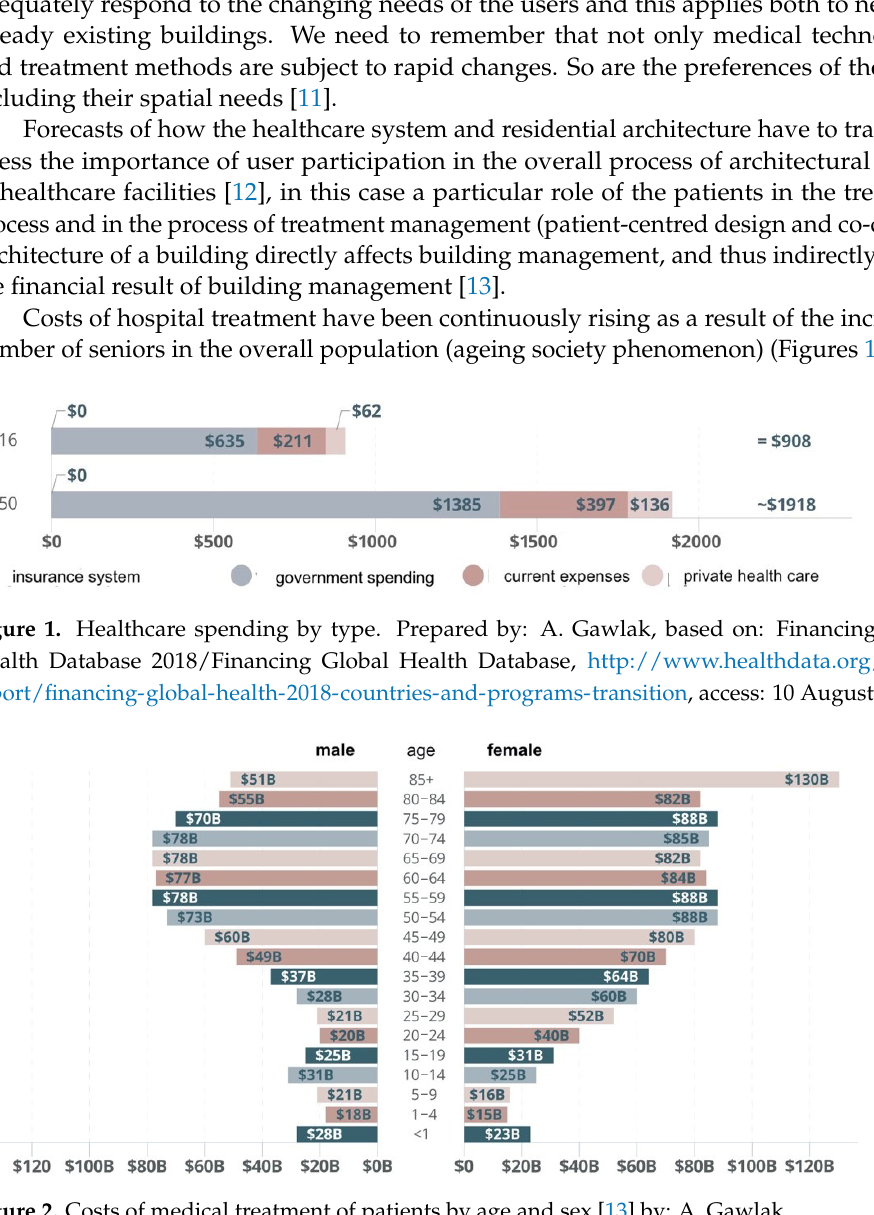
Figure 2. Costs of medical treatment of patients by age and sex [13] by: A.